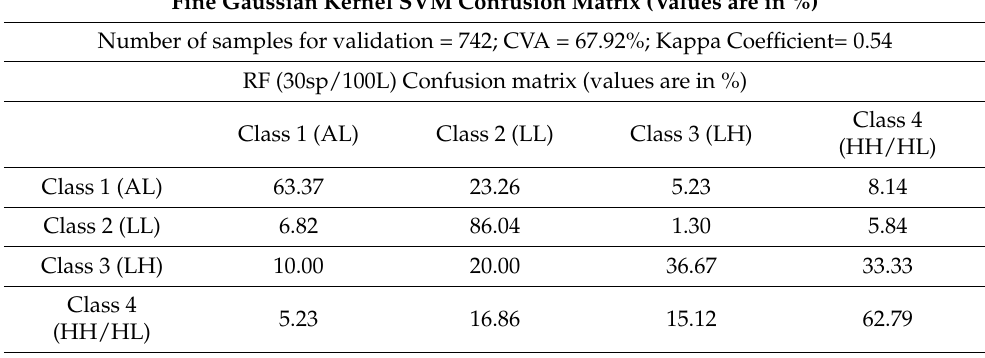
Table 8. Cont. Fine Gaussian Kernel SVM Confusion Matrix (Values are in %) Number of samples for validation = 742; CVA = 67.92%; Kappa Coefficient= 0.54 RF (30sp/100L) Confusion matrix (values are in